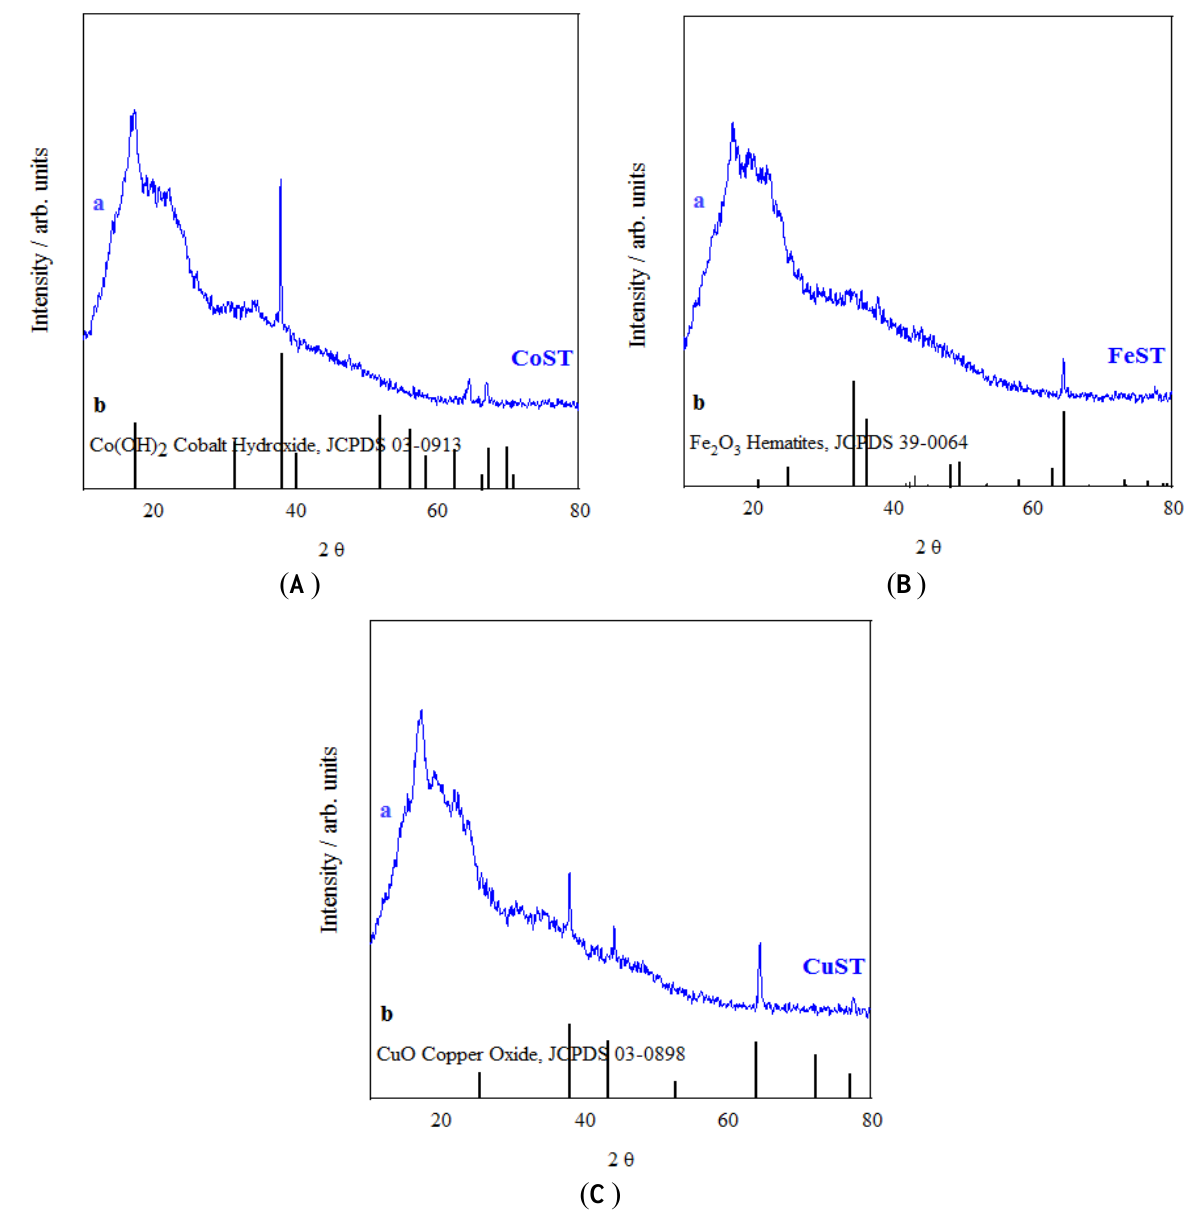
Figure 2. XRD diffraction patterns of ( A ) CoST; ( B ) FeST and ( C ) CuST. The bottom solid lines correspond to the metallic phases with respective JCPDS cards matching the diffraction lines found in the different